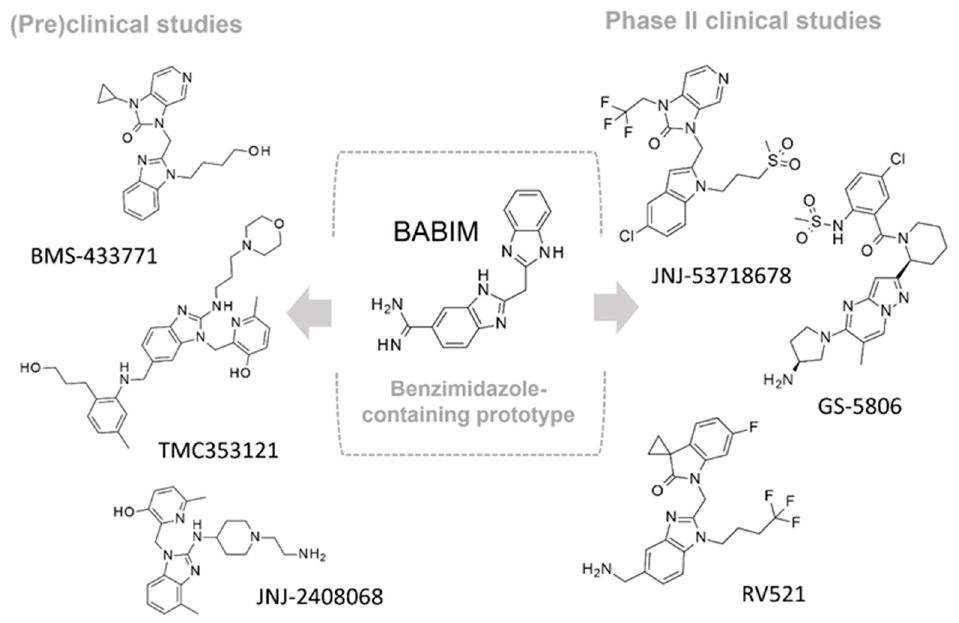
Figure 1. Main examples of preclinical and clinical benzimidazole-based derivatives targeting RSV F protein.